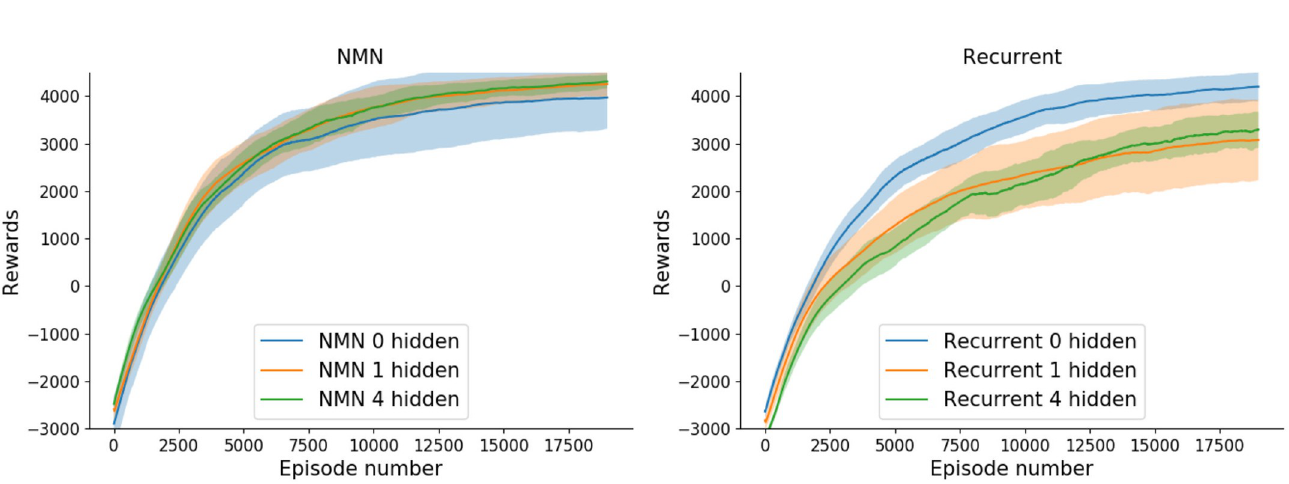
Fig 12. Mean ( ± std in shaded) sum of rewards obtained on benchmark 1 over 15 training runs with different random seeds with respect to the episode number. The plots are smoothed thanks to a running mean over 1000 episodes.